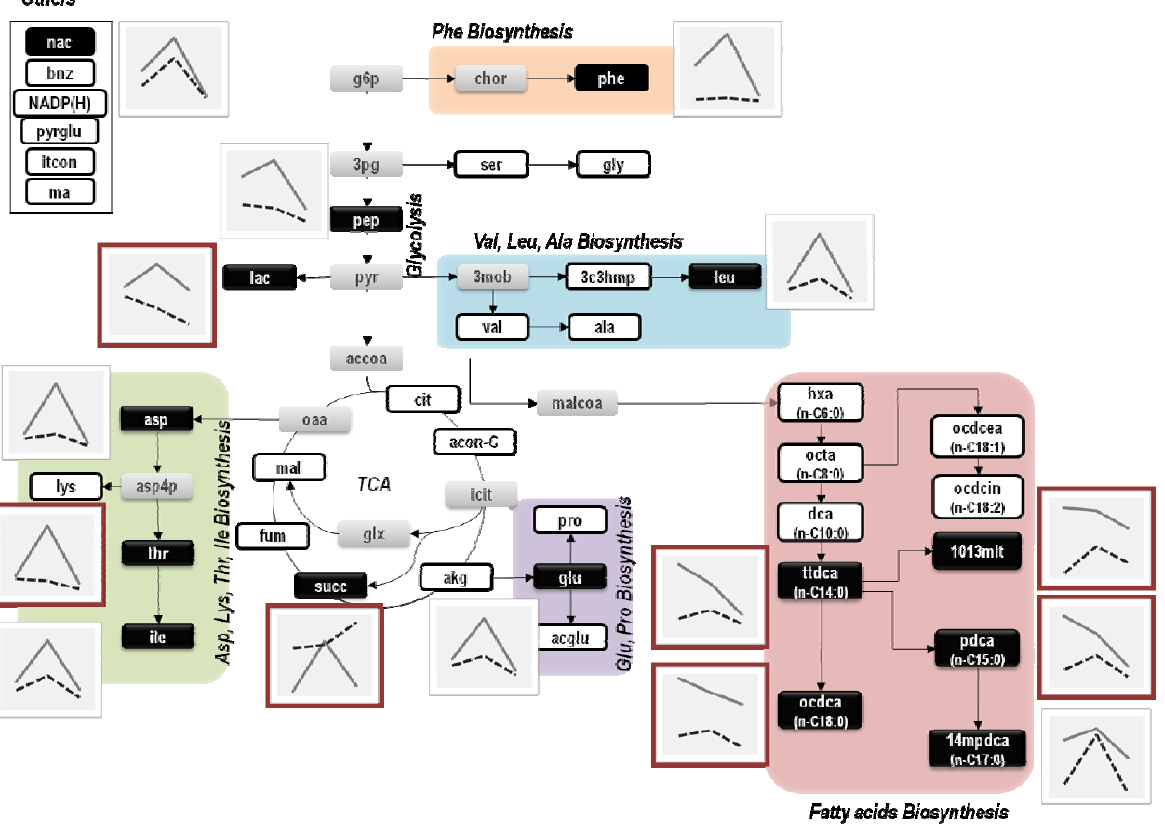
Figure 3. Representation of metabolic profiles on the metabolic map of E. coli . White and grey boxes represent metabolites that were respectively detected and undetected by the GC-MS analysis. Black boxes refer to metabolites that were found to change significantly according to the Mack-Skillings test. Each plot next to metabolite black boxes displays the corresponding metabolite profiles from each E. coli culture (dashed lines represent the metabolic profile of E. coli  rel A cultures and full lines represent the metabolic profile of E. coli W3110